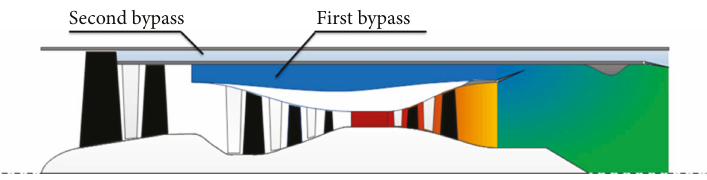
Figure 1: The con fi guration of three-stream ACE.